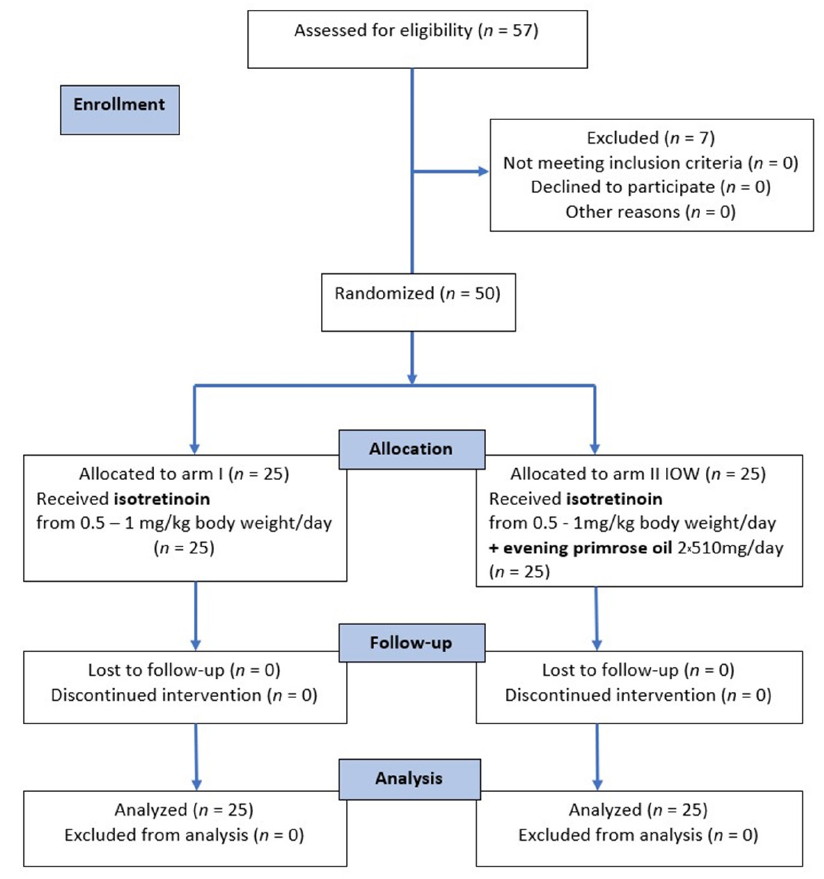
Figure 1. CONSORT 2010 flow diagram [50].